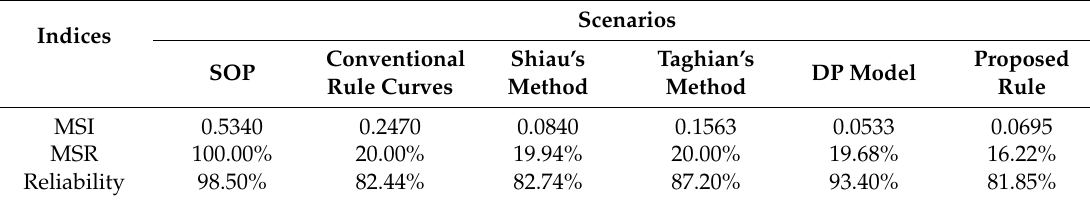
Table 2. The operation results of different scenarios.